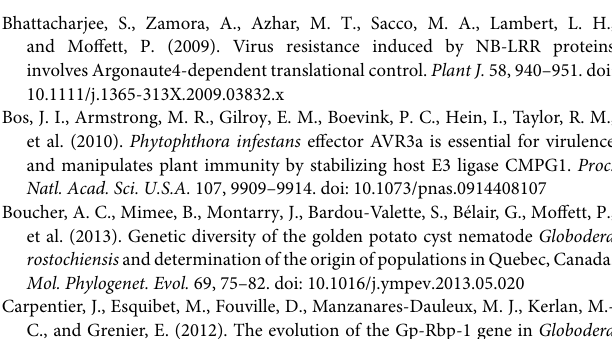
Figure S1 | Expression profile of Gr SPRYSEC-encoding genes in different life stages of Globodera rostochiensis . The relative expression of six SPRYSEC-encoding genes was determined using quantitative RT-PCR in five G. rostochiensis life stages: cyst, pre-parasitic second-stage juvenile (pre-J2) and parasitic second-, third- and fourth-stage juveniles (par-J2, J3, and J4). Values are means ± SD of two biological replicates, normalized to the G. rostochiensis β -actin gene ( Gract-1 ) (EF437156) and relative to expression in the cyst stage. Figure S2 | Suppression of the HR induced by the Phytophthora infestans elicitor Pi NPP in N. benthamiana by Gr SPRYSECs. (A,B) N. benthamiana leaves were co-infiltrated with Agrobacterium carrying expression vectors for Pi NPP and P38 together with either empty vector (EV, left hand side) or the indicated effectors (right hand side). Effectors were expressed from a PVX expression vector. Cell death symptoms were scored at 3–5 DPI and photographed at 5 DPI. Figure S3 | Suppression of the HR by Gr SPRYSECs in N. tabacum induced by AvrBs2 and Bs2. (A,B) N. tabacum leaves were co-infiltrated with Agrobacterium carrying expression vectors for AvrBs2/BS2 and P38 together with either empty vector (EV, left hand side) or the indicated effectors (right hand side). Effectors were expressed from a PVX expression vector. Cell death symptoms were scored at 3–5 DPI and photographed at 5 DPI. Figure S4 | Sequence alignment of Gr SPRYSEC-4 and Gr SPRYSEC-15 with corresponding reference genes. Nucleotide sequences of previously described reference genes (ref; see Table S2 ) vs. those found in the Québec populations (QC) used in this study were aligned. Shown in red are predicted coding sequences, excluding the portion of the mRNA encoding the signal peptide, which was not amplified in this study. (A) Sequence of reference GrSPRYSEC-4 (JX026913.1) compared to GrSPRYSEC-4 (K963513.1) reported herein. (B) Sequence of reference GrSPRYSEC-15 (JX026918.1) compared to GrSPRYSEC-15 (K963515.1) reported herein. Table S1 | Primers used in this work. Table S2 | Sequence variation from reference genes of SPRYSEC-coding genes from Globodera